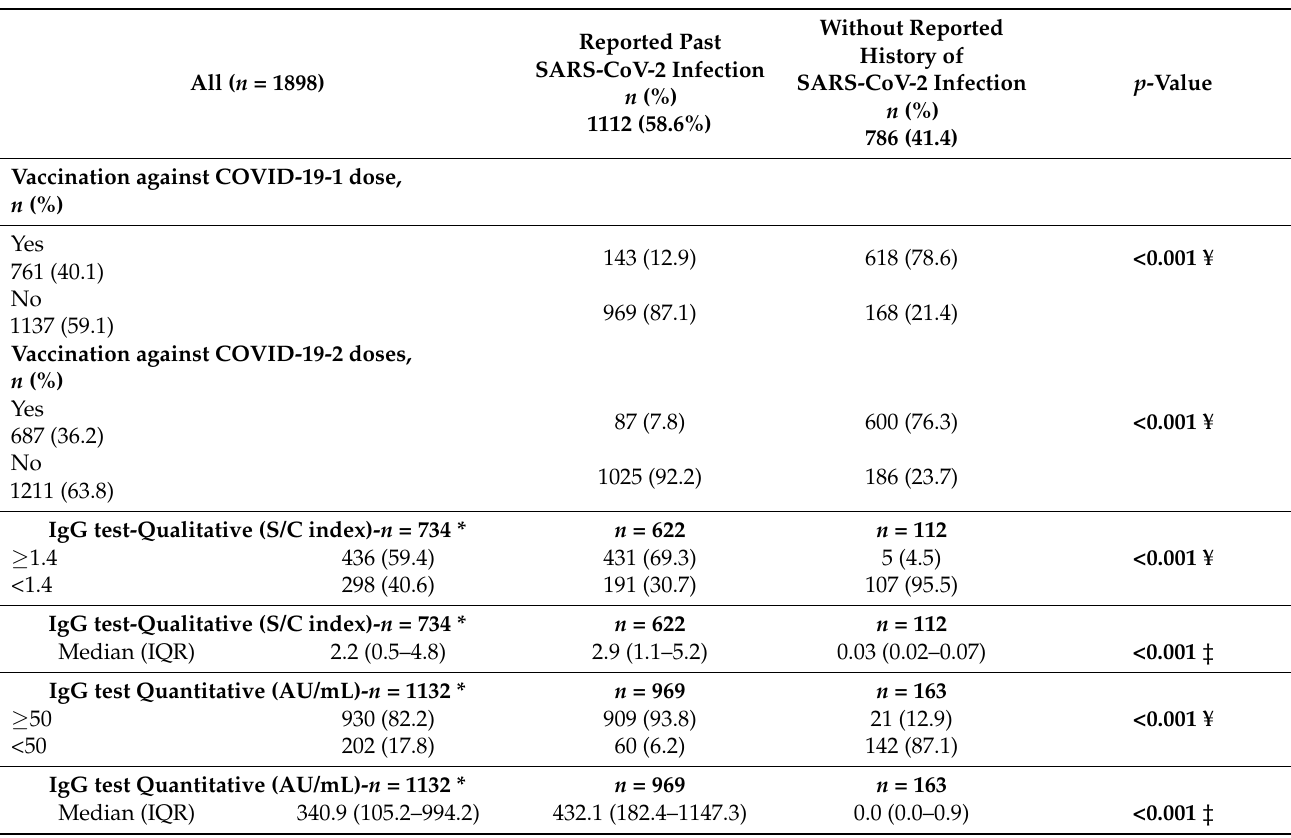
Table 2. Results of tests for anti-SARS-CoV-2 immunoglobulin class G (IgG) targeting the nucleocapsid protein (qualitative method; SARS-CoV-2 IgG—Abbott Laboratories) and the receptor binding domain of the spike protein (quantitative method; SARS-CoV-2 IgG II Quant—Abbott